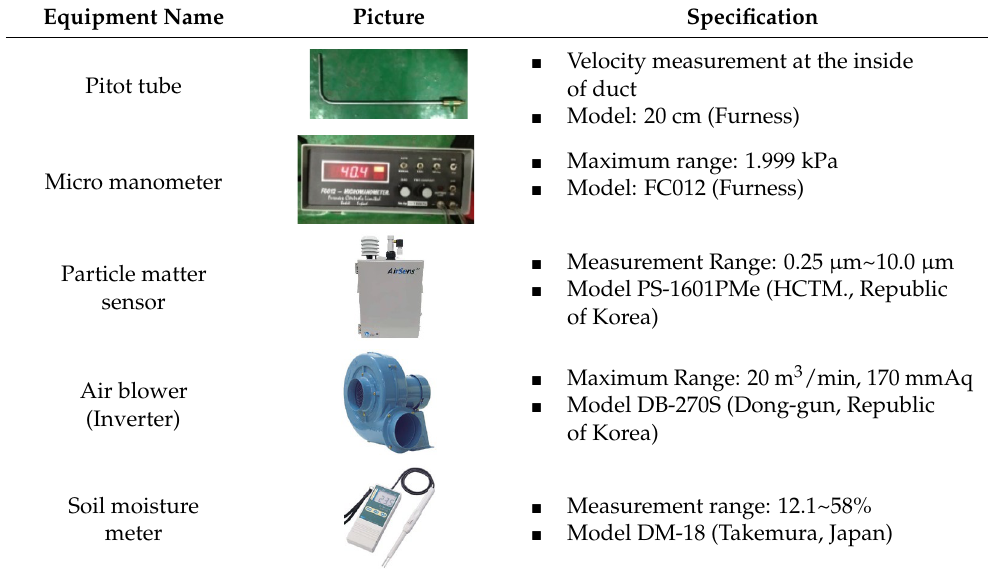
Table 2. Specifications of the main measurement equipment.